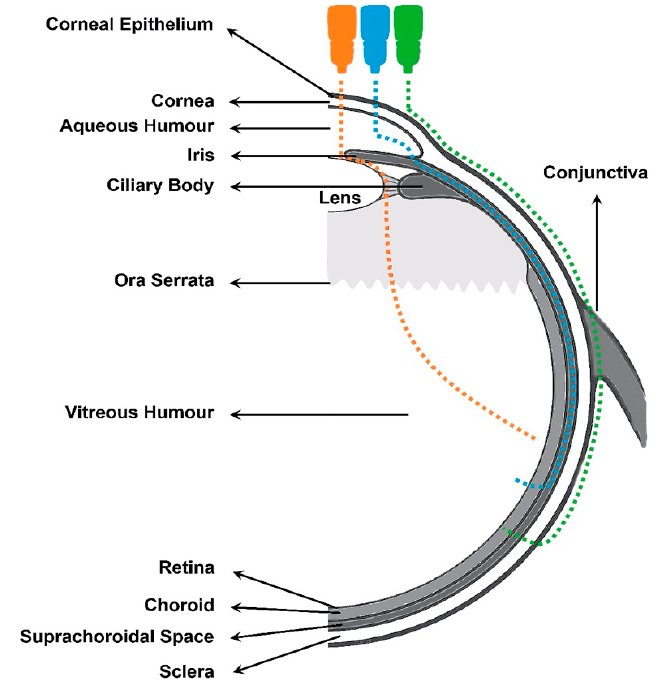
Figure 7. Different topical routes of drug absorption from the cornea/conjunctiva to the vitreous humor: Periocular route marked in green. Uvea-scleral route in blue. Transvitreal route marked in orange.